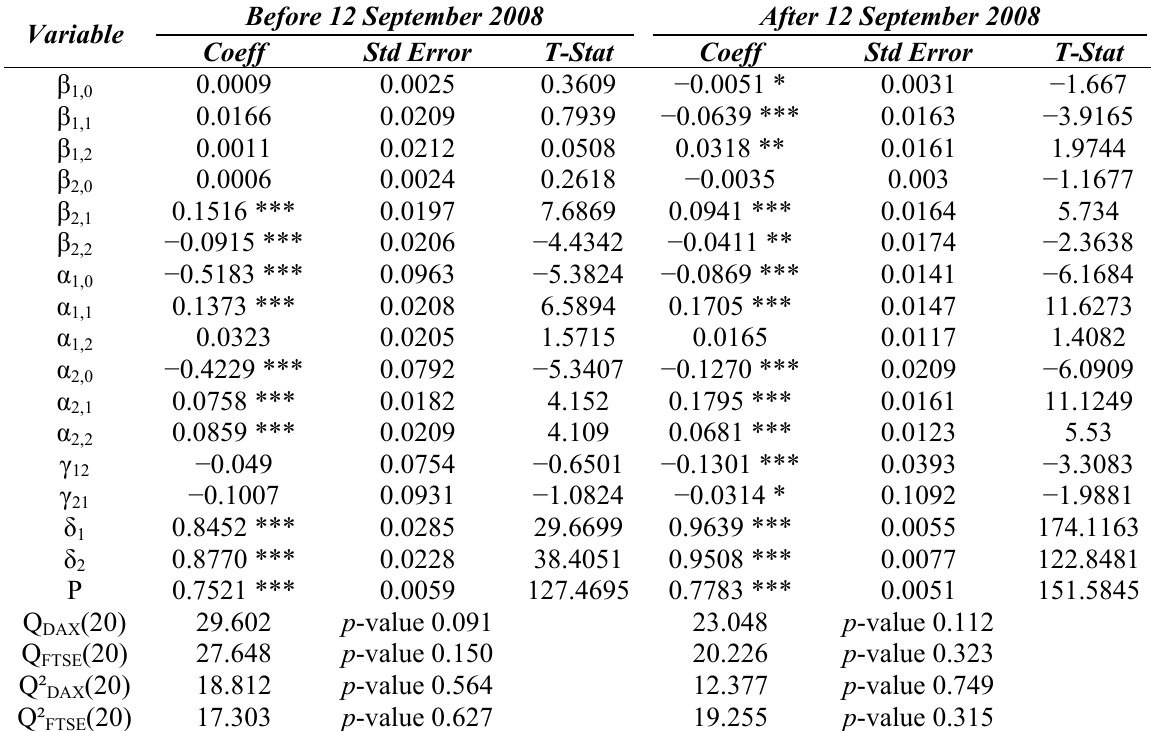
Table 3. VAR (1) EGARCH (1,1) DAX 30 FTSE 100 estimates.